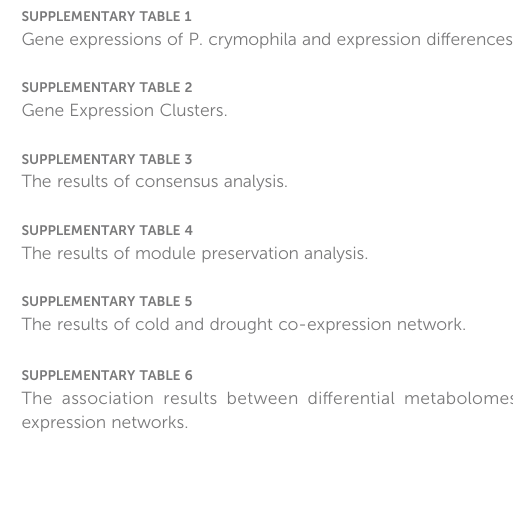
SUPPLEMENTARY TABLE 6 The association results between differential metabolomes and co- expression